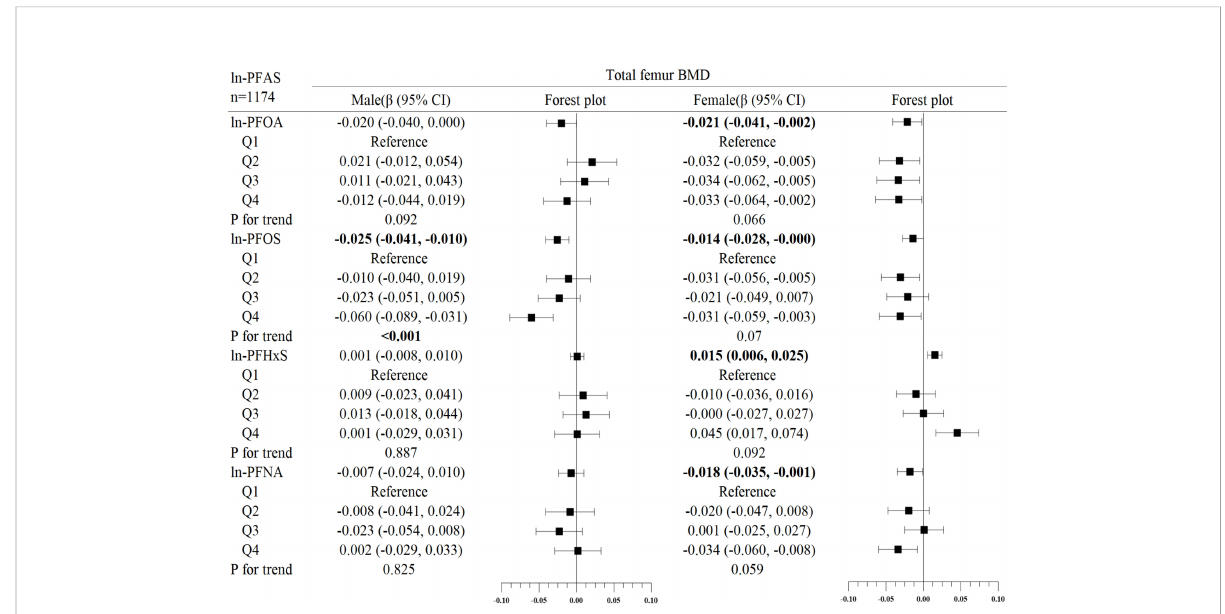
FIGURE 2 Association between ln-PFOA and bone mineral density, strati fi ed by gender. Adjusted for age, race, income poverty ratio, serum cotinine, vigorous physical activity, moderate physical activity, BMI, serum lead, albuminuria, and anemia. The bold values indicate signi fi cance (p<0.05).